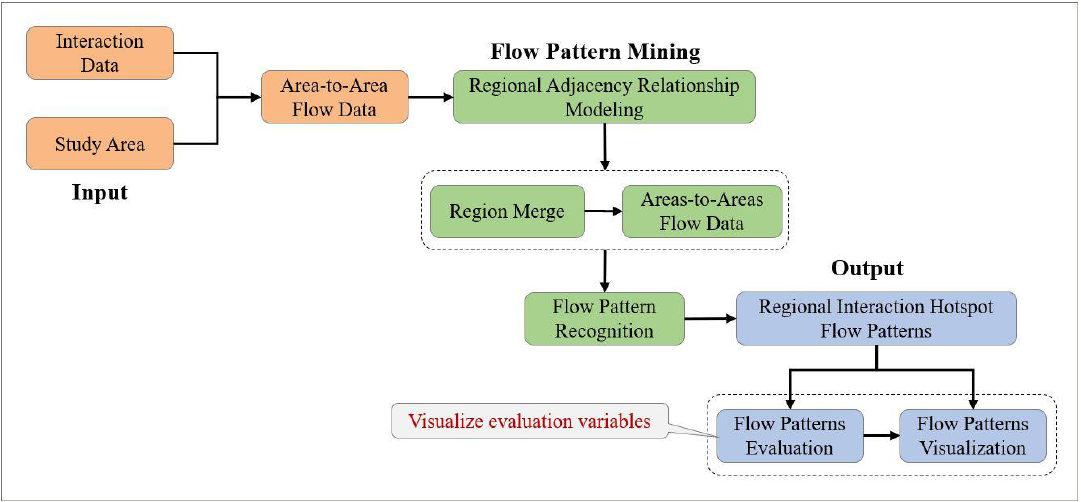
Figure 4. Overview of the framework for the analysis and visualization of similar flow hotspot patterns between regional groups.